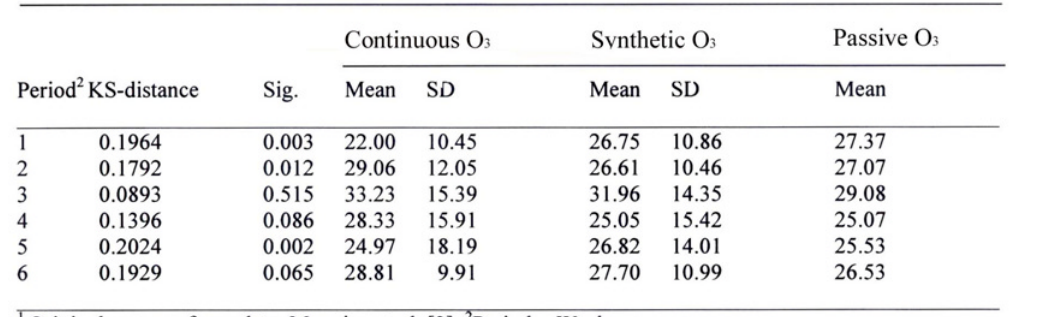
Concentrations (ppb, 3